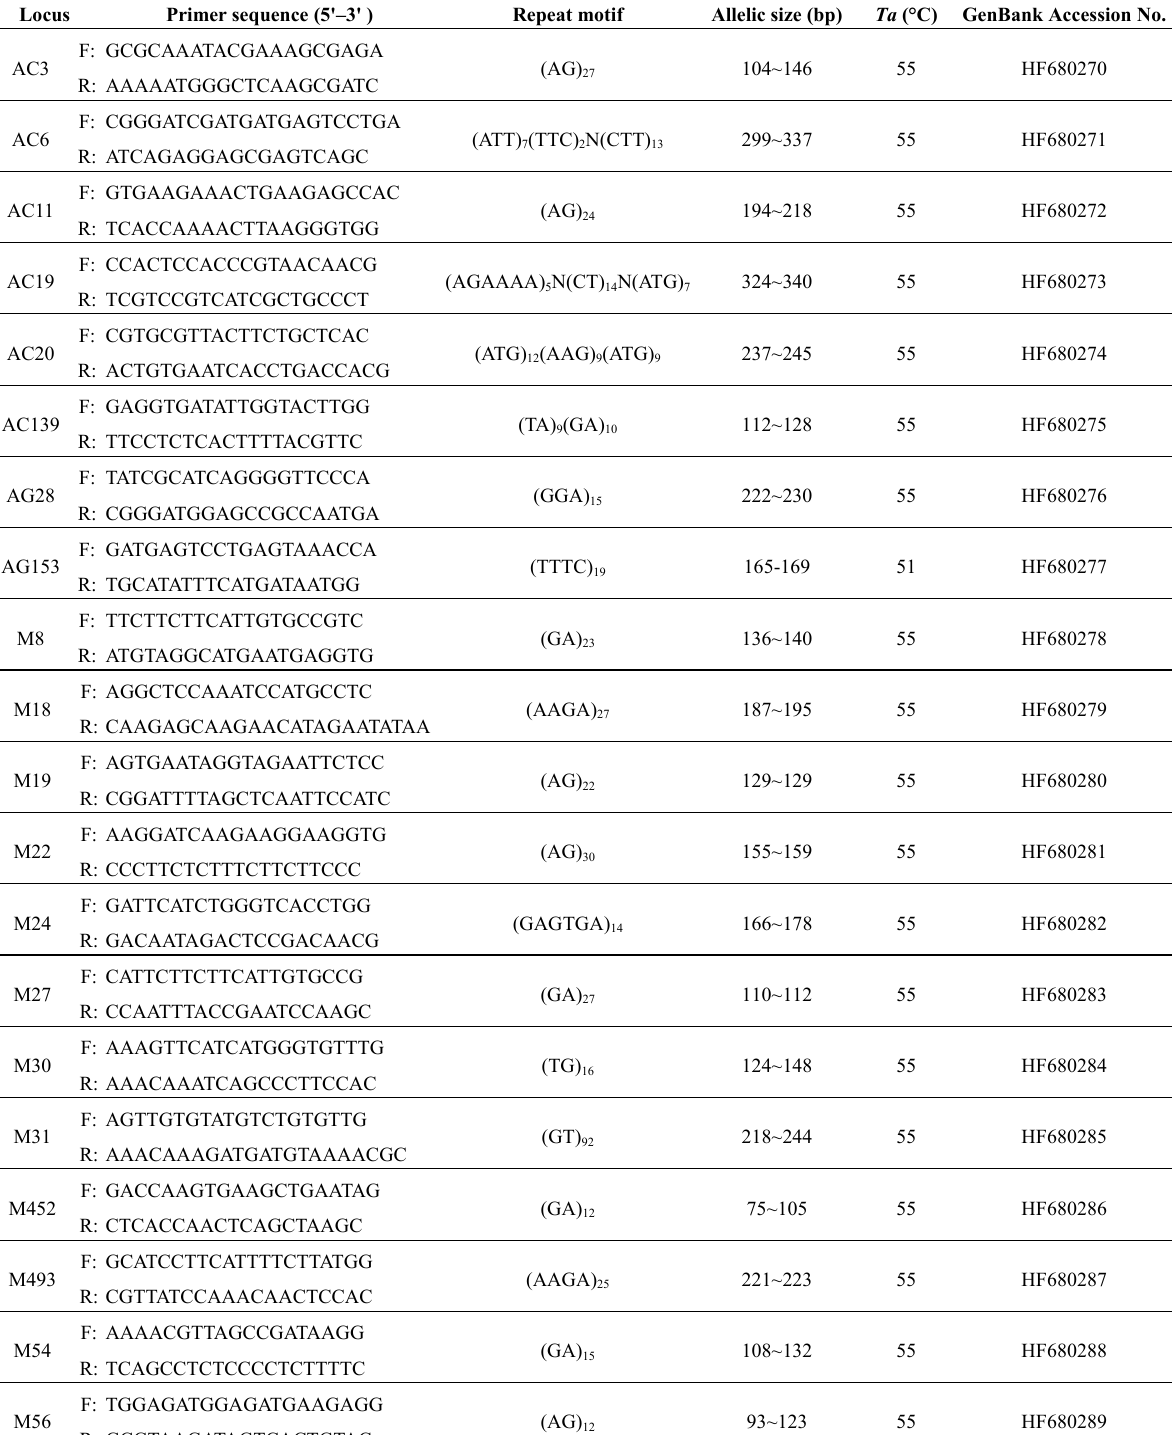
Table 1. Characteristics of 42 microsatellite loci isolated from Toxicodenderon radicans .